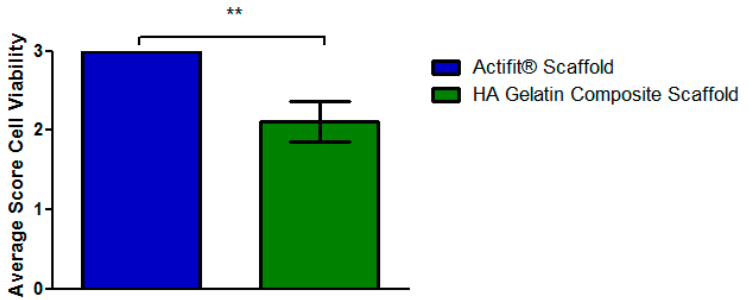
Figure 11. Overall Scoring Results of the different scaffolds. Error bars indicate 95% confidence interval.